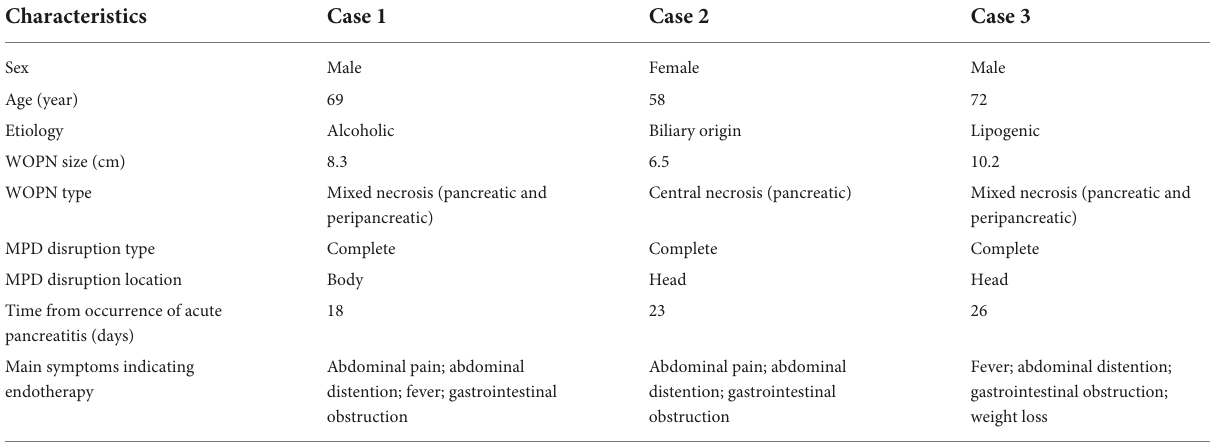
TABLE 1 Characteristics of the three patients with walled-off pancreatic necrosis (WOPN) and complete disruption of the main pancreatic duct.